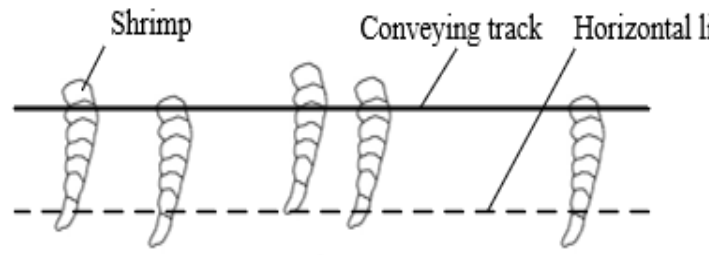
Figure 1. Symmetrically supported head-to-tail orientation: A is the left support point; B is the right support point; and C is the center of gravity of shrimp.